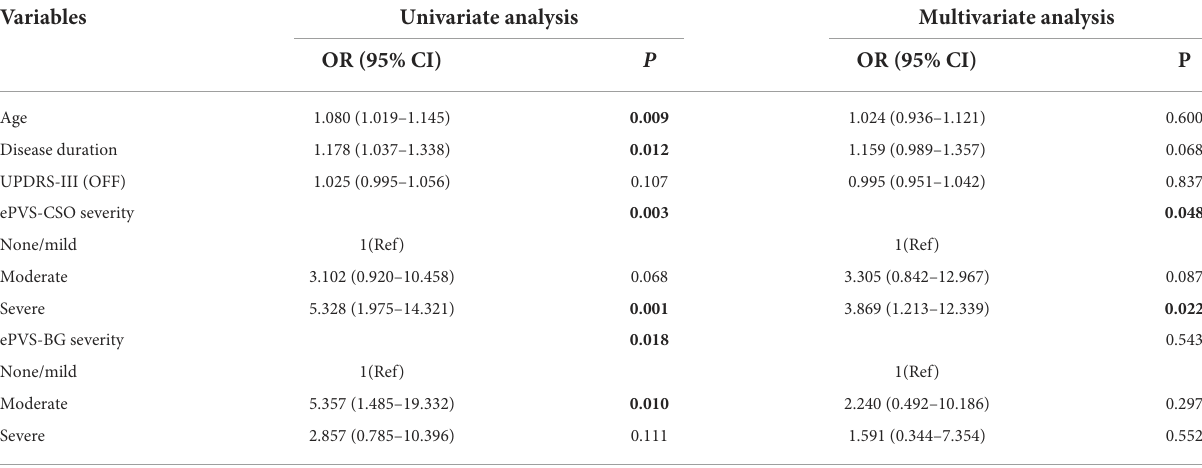
TABLE 2 Univariate and multivariate logistic regression analysis for the association of enlarged PVS with FOG in PD patients.